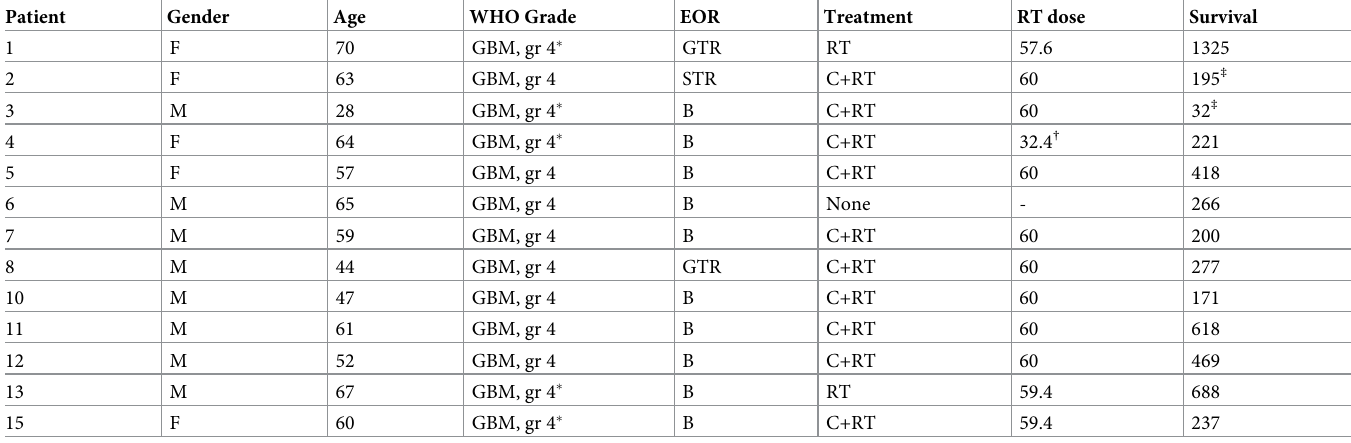
Table 1. General characteristics of included patients.